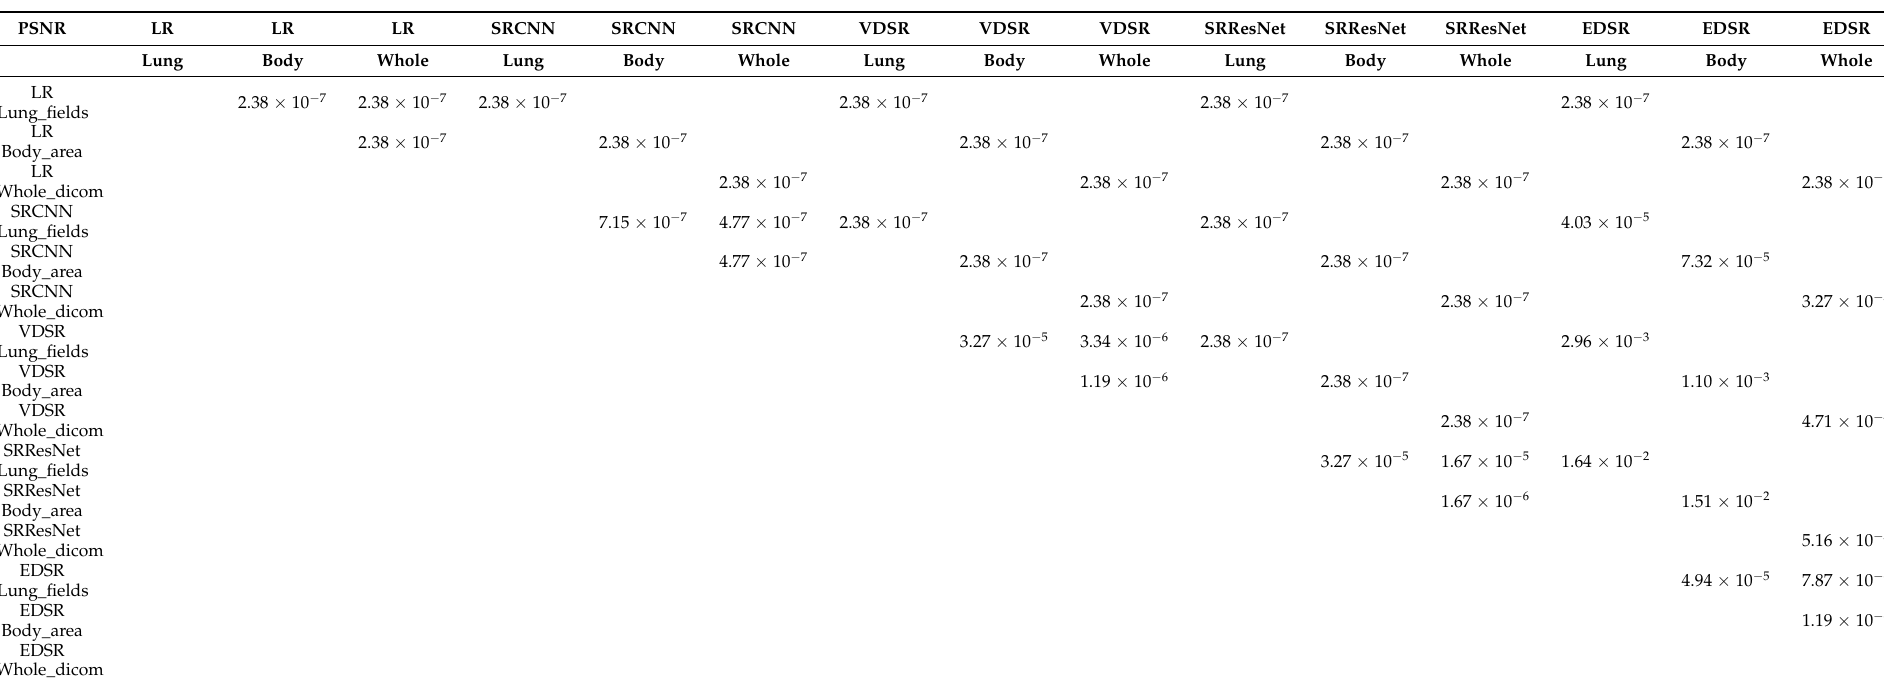
Table 8. p -values for comparing PSNR and SSIM values between different SR models applied to different ROIs. The SR methods in rows are better than those in columns when the corresponding p -values after Bonferroni correction are less than 1.11 × 10 − 3 in a one-sided Wilcoxon signed rank test. We did not count the p-values for different methods applied to different ROIs because they have no practical